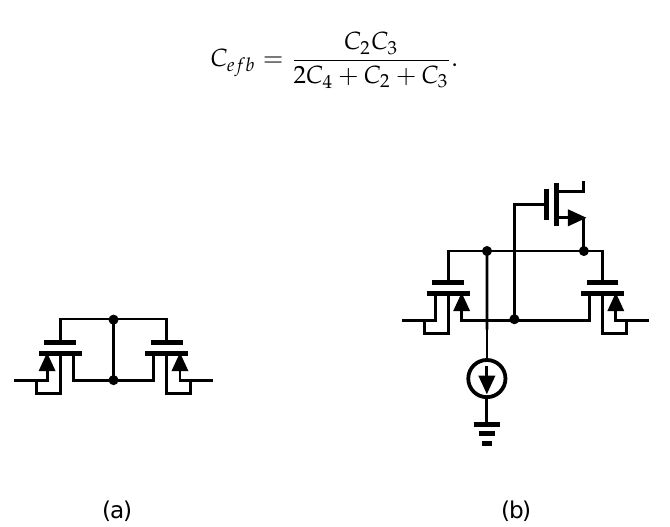
Figure 15. Pseudo-resistor architectures. ( a ) Fixed-value and ( b ) tunable pseudo-resistor.